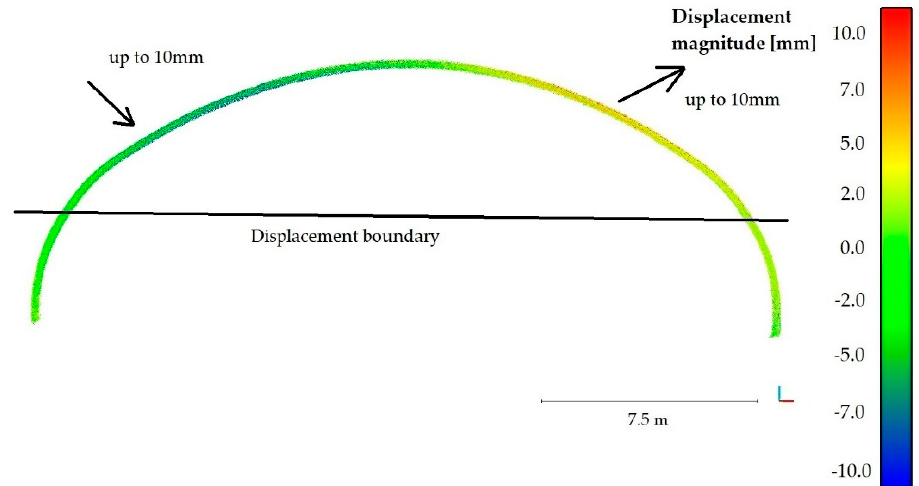
Figure 18. Displacements of the unloaded steel shell 2-2 section one year after the final acceptance and inspection tests.